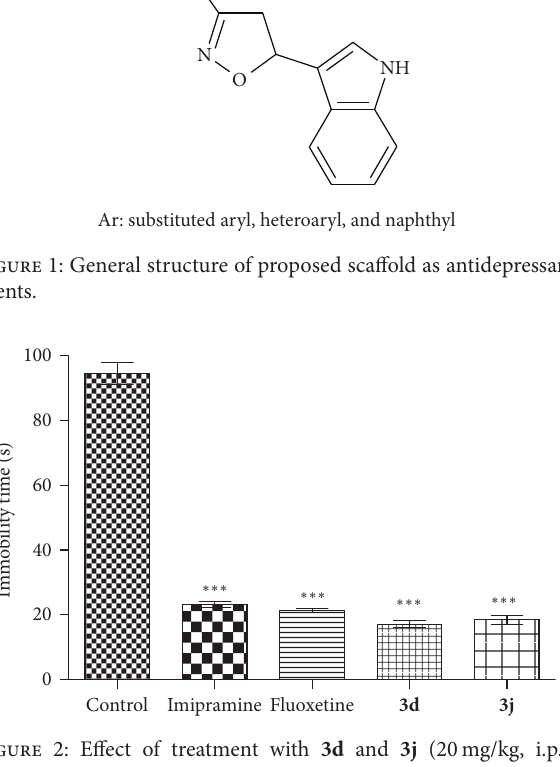
F 2: Effect of treatment with 3d and 3j (20mg/kg, i.p.), imipramine (20mg/kg, i.p.), and �uoxetine (20mg/kg, i.p.) on the immobilitytimeinforcedswimtest.(Valuesarerepresentedasmean , compared S.E.M. . Values are signi�cant at with control ∗∗∗ 𝑃𝑃 𝑃 𝑃𝑃𝑃𝑃𝑃 ± (𝑛𝑛 𝑛 𝑛𝑛